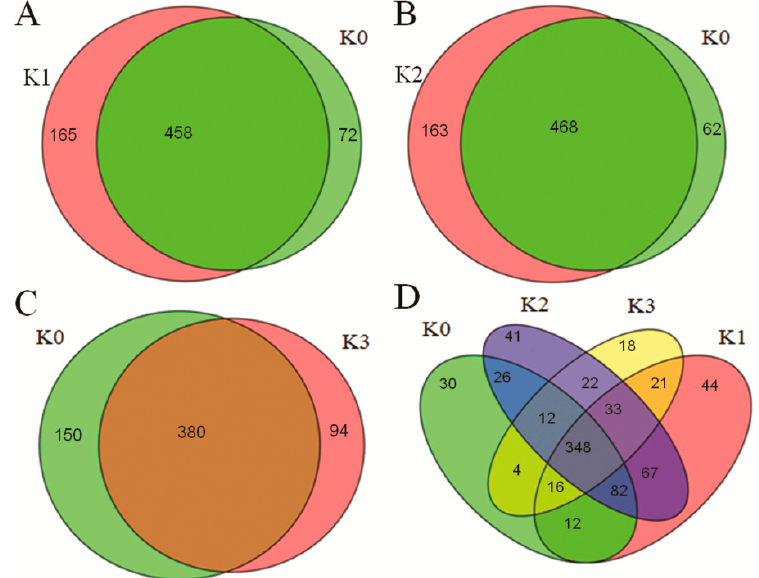
Figure 2. A summary of unique miRNAs detected in four libraries. ( A – C ) The miRNAs responded specifically the D. zeae infection in an incompatible interaction at 6, 12 and 48 h compared with at 0 h respectively. ( D ) The specific miRNAs were detected among four libraries.